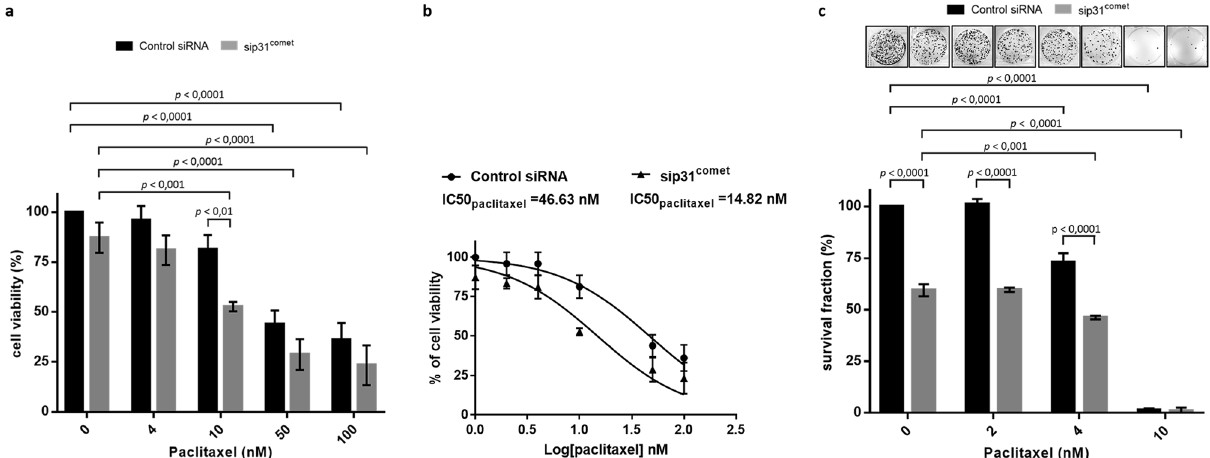
Figure 2. p31 comet inhibition enhances paclitaxel-mediated toxicity in NCI-H460 cells under low doses of paclitaxel. ( a ) Cell viability, as determined by MTT assay. Twenty-four hours post-transfection with control or p31 comet siRNAs, paclitaxel was added at the indicated concentrations (0–100 nM) and cells were incubated for an extra 48 h. ( b ) Dose response curves and IC50 values for paclitaxel treatment of control or p31 comet siRNA-transfected cells. ( c ) Cells were treated as in ( a ), washed and allowed to grow for 10 days for colony formation assays. Results are the mean from three independent experiments, expressed as % of survival fraction. Representative images of surviving colonies (top) are shown for each condition. Statistical analysis was performed by two-way ANOVA with Tukey’s multiple comparisons test. The error bars represent mean ± SD.